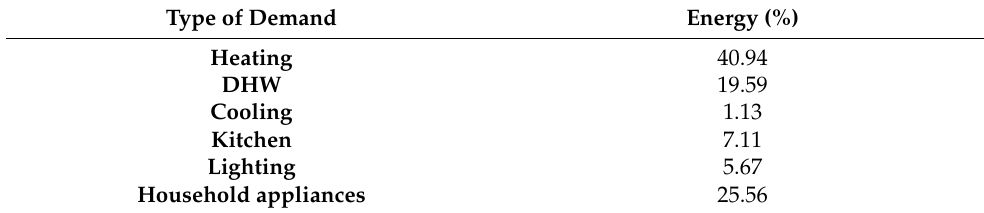
Table 3. Energy demand per dwelling—SECH-SPAHOUSEC project.